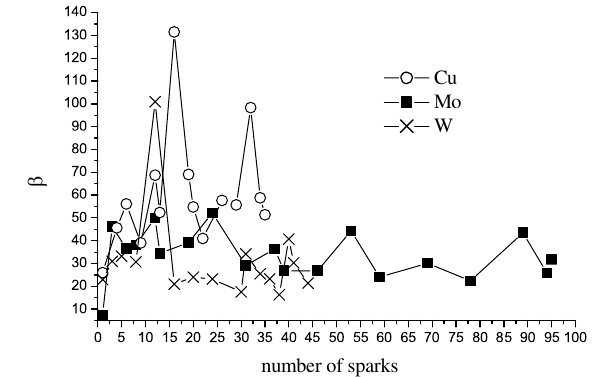
FIG. 3. Field enhancement factor (cid:1) as a function of the number of sparks for one site on Cu (circles) , Mo (squares), and W